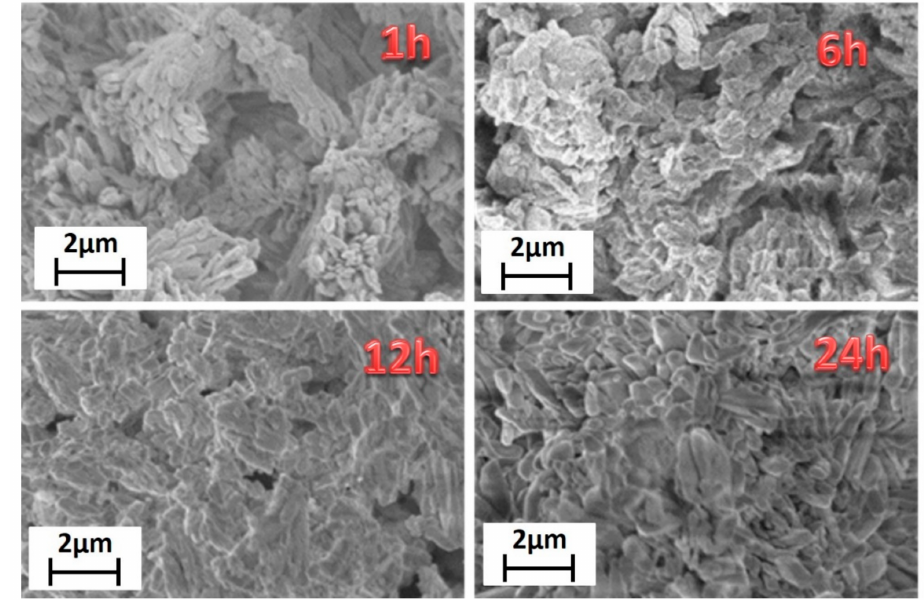
Figure 2. FE-SEM images of the [Gd 2 (BDC) 3 (H 2 O) 4 ] synthesized for 1 h, 6 h, 12 h and 24 h. Lower reaction time, 1 h, gives rise to bundles of nanorods of about 200–300 nm in diameter. Upon increasing the reaction time, the grain size increases, with dimensions of about 500–600 nm for the highest reaction time of 24 h. This is due to the effect of temperature for a prolonged time that allows a sintering of the network structure yielding larger and more crystalline grains. The energy dispersive X-ray (EDX) analysis (Figure S2) confirms the formation of the Gd-MOF structure, the spectrum showing all the expected peaks: the L and M emission lines of Gd are observed in the 6–7.5 keV range and at 1.2 keV, respectively; the C K α and O K α peaks found at 0.28 and 0.52 keV, respectively; the Au M peaks due to the sputtered layer around 2.1